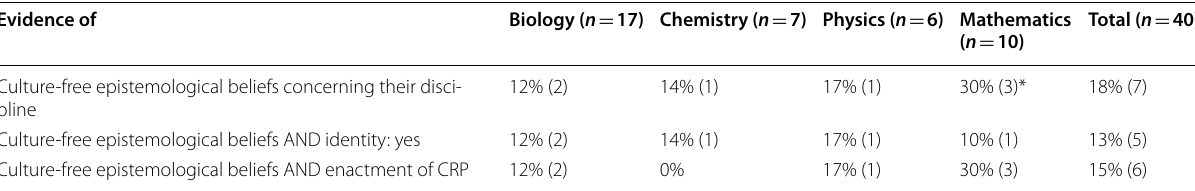
Table 5 Percentage (and number) of participants that expressed culture-free beliefs and also expressed consideration of student identity or enactment of CRP in their teaching